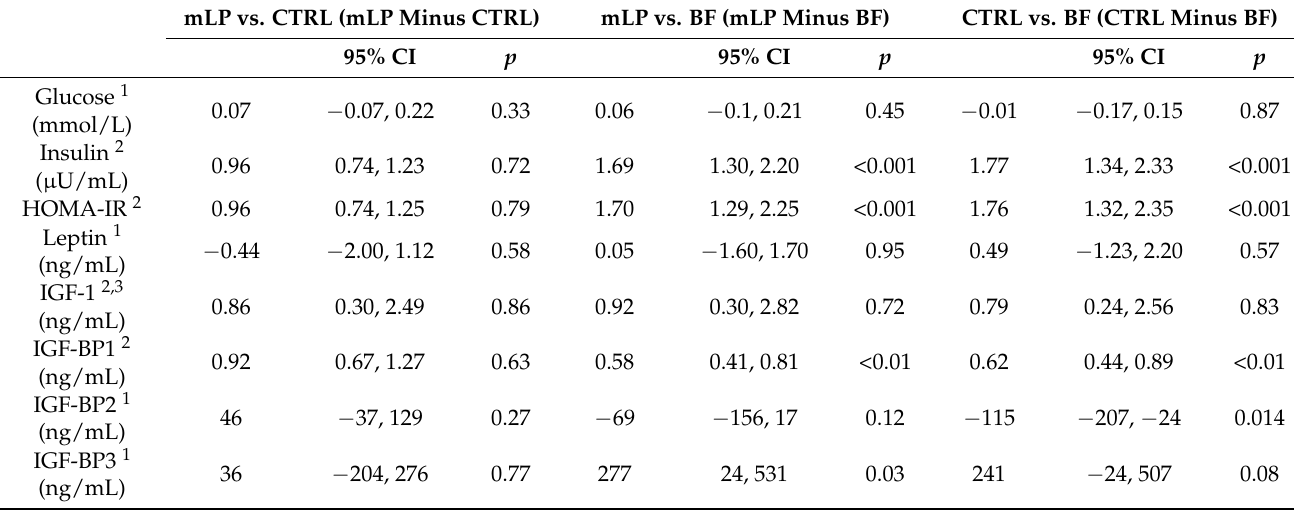
Table 4. Differences in metabolic and hormonal markers between feeding groups at 4 months of age.